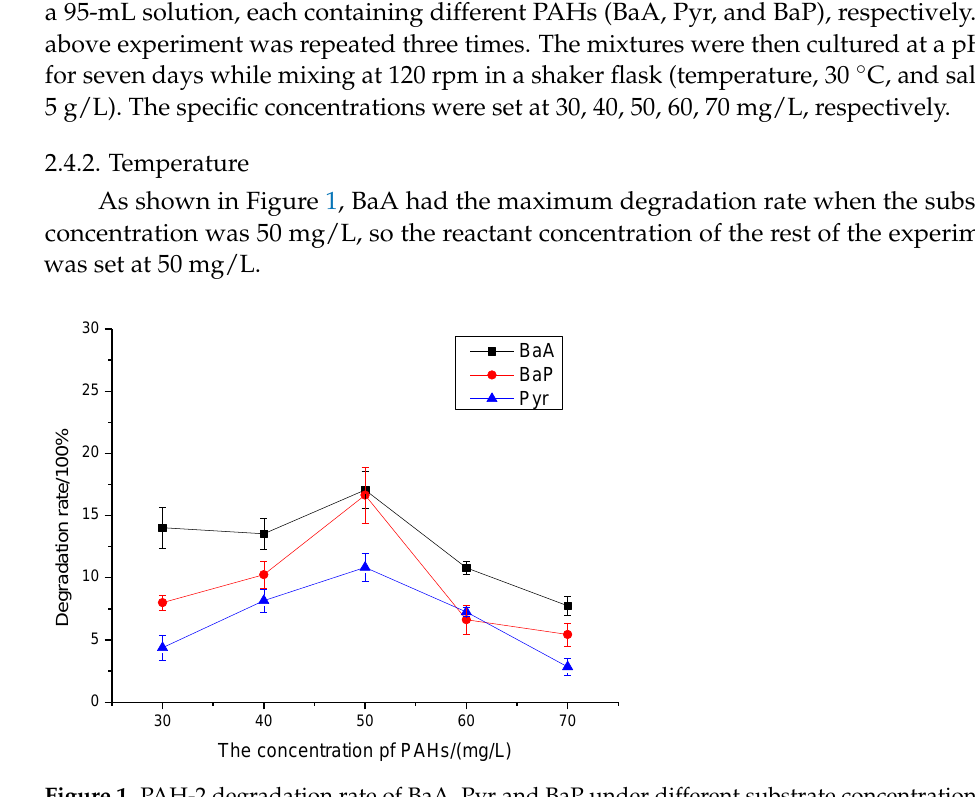
Figure 1. PAH-2 degradation rate of BaA, Pyr and BaP under different substrate